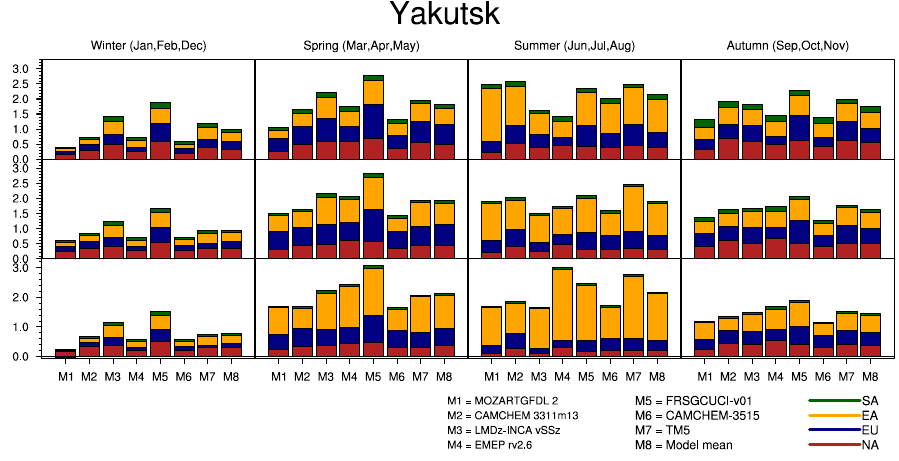
Fig. 19: Model-calculated effect above Trinidad Head on O 3 (ppb) of 20% reductions in emissions in the four source regions in winter, spring, summer and autumn calculated with the first seven models (and the model mean) listed in Table 1 (see legend above). Results are aggregated to LT (900 - 700hPa), MT (700 - 500hPa) and UT (500 - 300hPa).